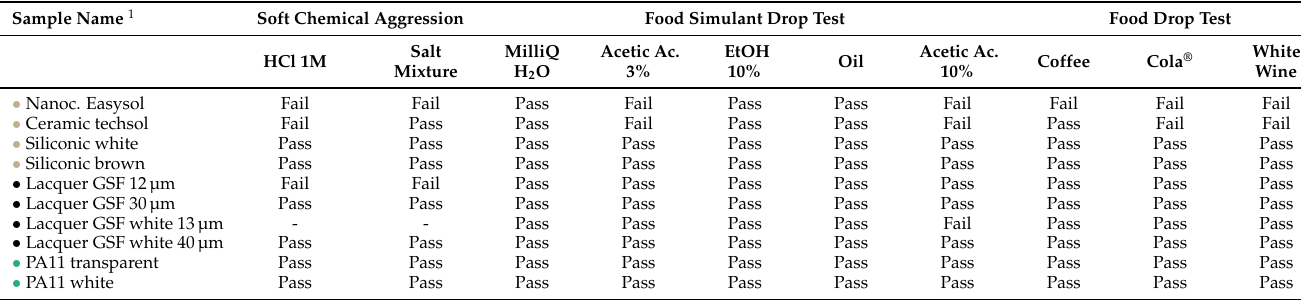
Table 1. Results of the food and soft chemicals tests for all tested samples.